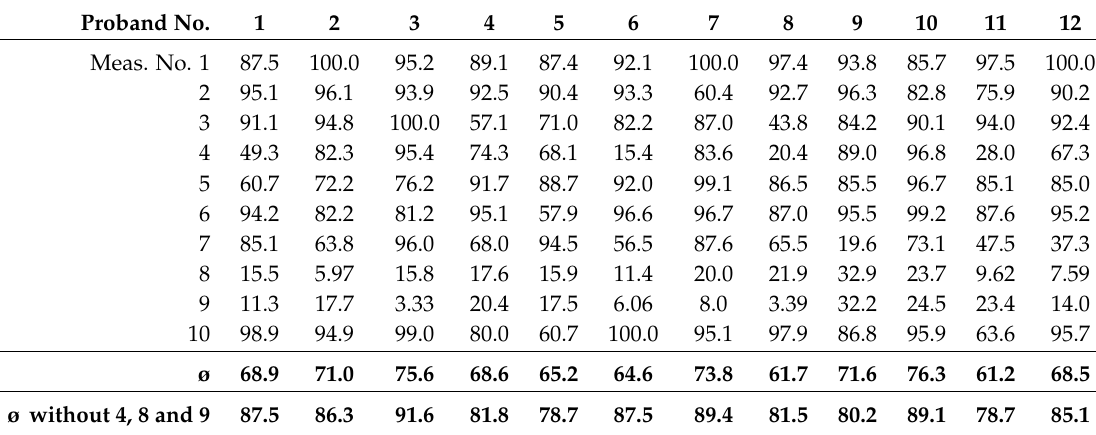
Table 6. F 1 -score (in %) of the classified PCG by using the